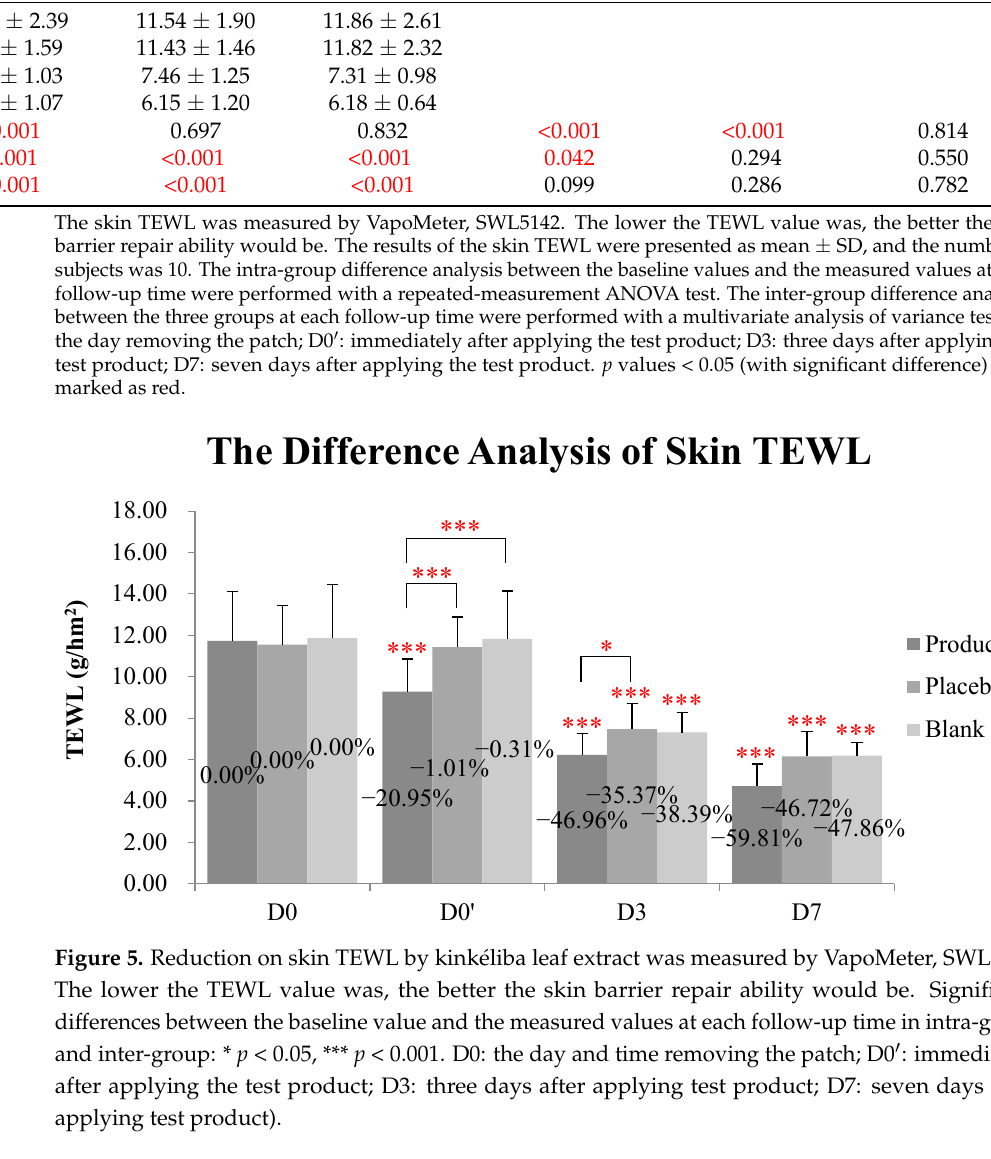
Table 1. Difference analysis of skin TEWL.